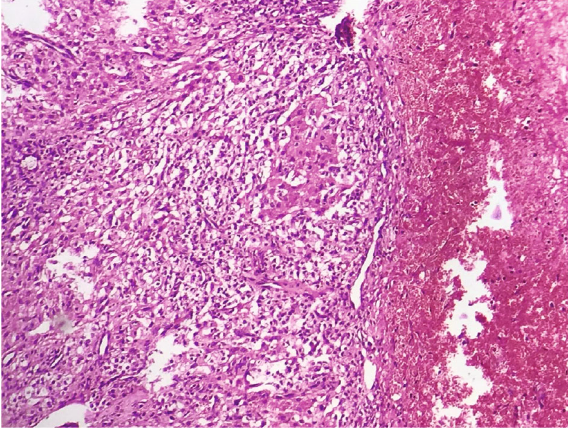
Figure 6: Granulomas in variable size (HE, G ×